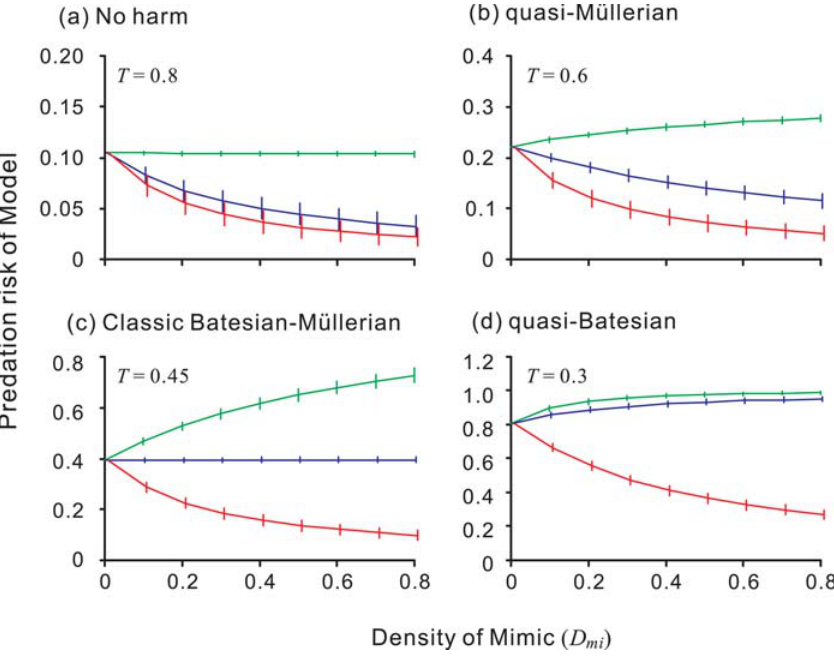
Figure 1. The four possible Model–Mimic relationships. Each point and error bar represent the mean and standard deviation of the replications. Blue, green, and red lines denote the Model’s predation risk when a highly palatable Mimic ( X mi =0.8), neutrally edible Mimic ( X mi =0.5), or highly unpalatable Mimic ( X mi =0.2), respectively, invades. (a) no harm: not even a highly palatable Mimic ( X mi =0.8) increases the risk of predation on the Model; (b) quasi-Mu¨llerian: a moderately palatable Mimic (0.5 # X mi , 0.8) decreases the predation risk; (c) classical Batesian–Mu¨llerian dichotomy: if the Mimic is palatable ( X mi , 0.5), it increases the predation risk of the Model, but if the Mimic is unpalatable ( X mi . 0.5), it decreases the predation risk. A neutrally edible Mimic ( X mi =0.5) has no effect on the Model’s predation risk; (d) quasi-Batesian: even a moderately defended Mimic ( X mi , 0.5) increases the predation risk. The negative effect of the Mimic on the Model increases in this order. The other simulation parameters, w , Q and density of Model ( D mo ), were fixed at 0.5, 0.02 and 0.2, respectively. The predator’s decision-making rule was ‘all-or-nothing’. The threshold parameter T denotes the abundance of the alternative prey.